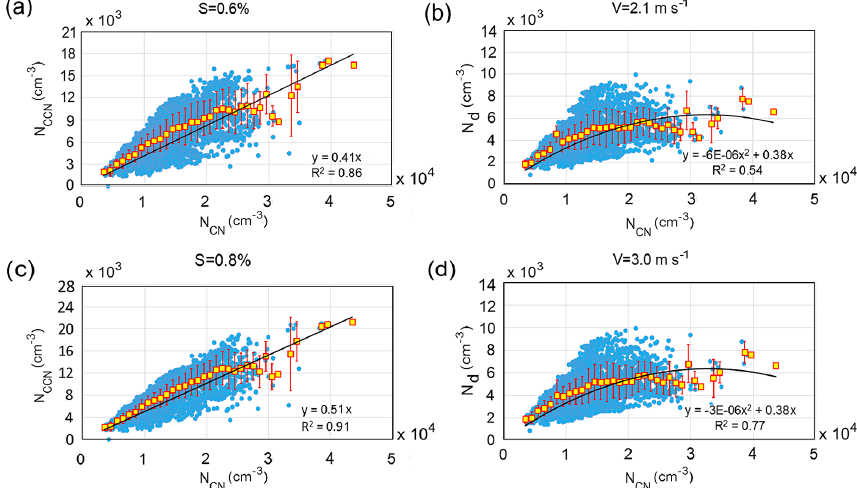
Figure 4. Scatter plots of correlation between total number concentration ( N CN ) and CCN number concentration ( N CCN ) at supersaturation of (a) 0.6% and (c) 0.8% respectively. Scatter plot of correlation between N CN and cloud droplet number concentration ( N d ) at updraft